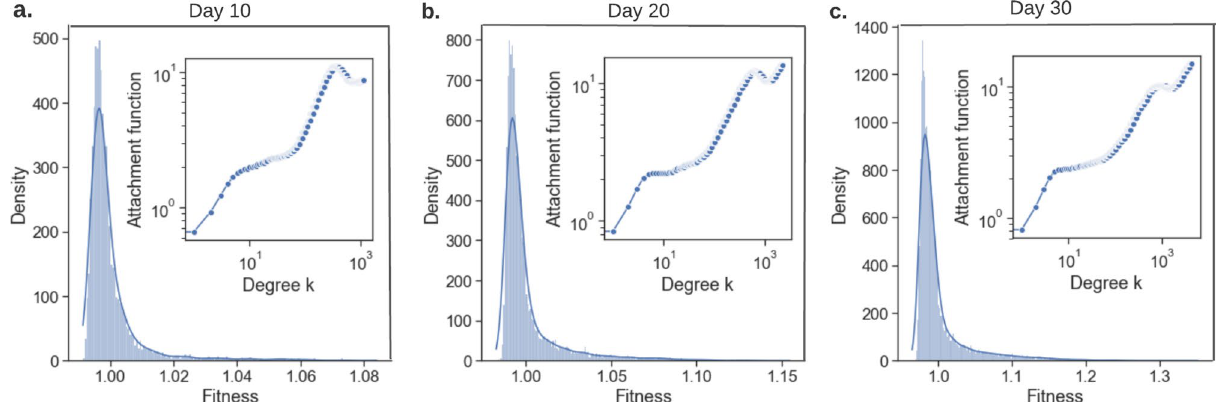
Figure 3. Node fitness and PA function (shown as in-plot) co-estimation for nodes in the misinformation networks on days 10 ( a ), 20 ( b ) and 30 ( c ). The heavy tails of fitness distributions show the existence of the fit get richer phenomenon. The estimated PA functions imply that the higher the node degree, the more competitive the node is in terms of link competition; it also shows a rich get richer